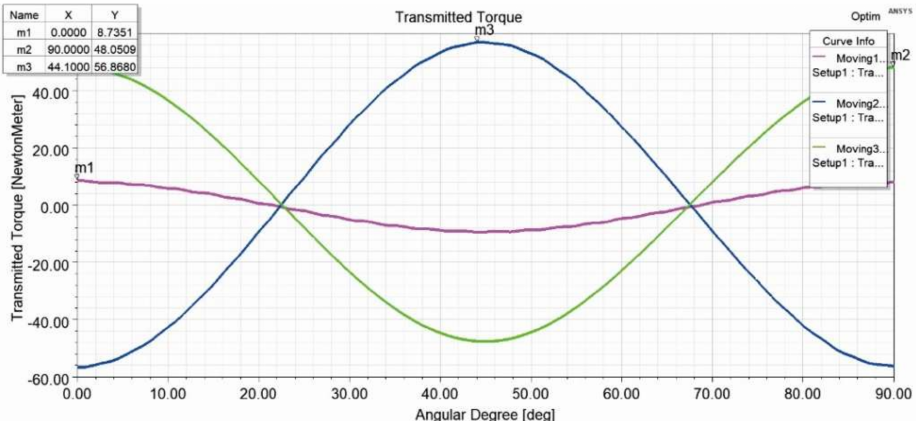
Figure 11. Transmitted